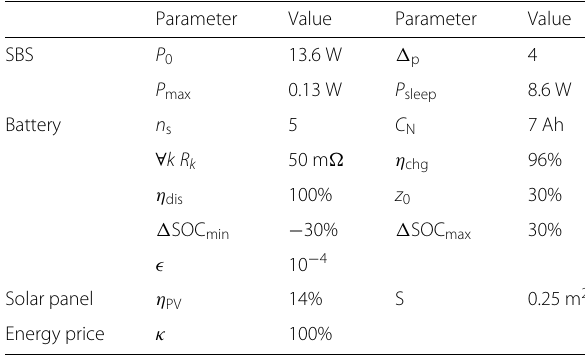
Table 1 Simulation parameters Table 2 Battery thermal and aging simulation parameters [28, 35]